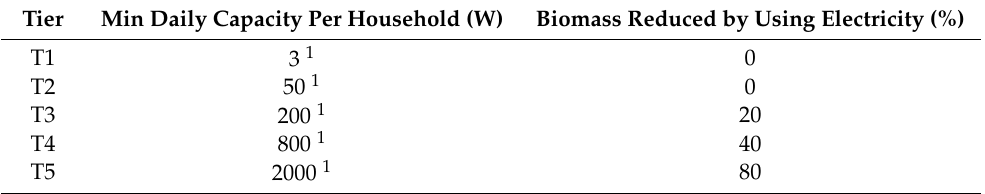
Table 4. Electrification scenarios.